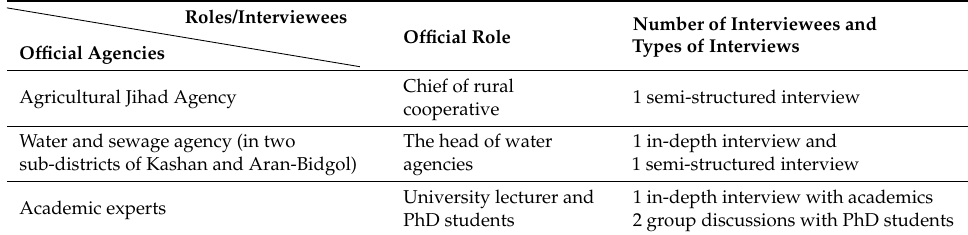
Table 4. Key governmental departments interviewed (2011 and